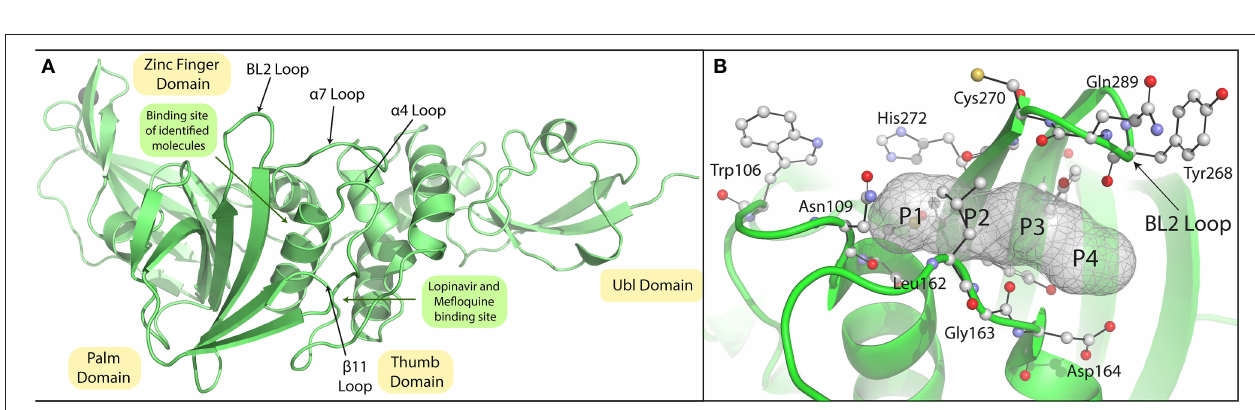
Frontiers in Microbiology |